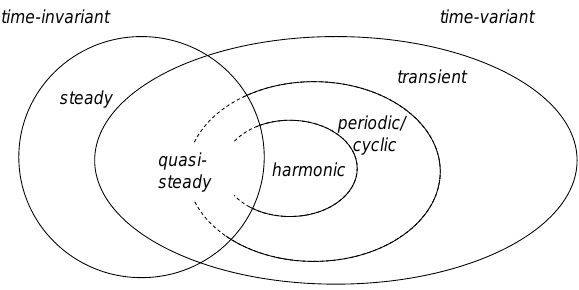
Fig. 2. Euler diagram for classification of time-variant and time- invariant processes, adopted from [2].